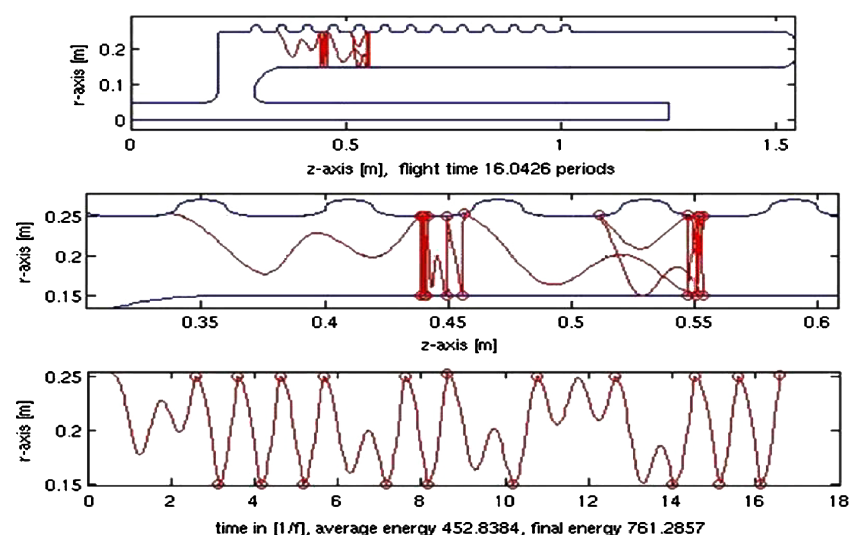
FIG. 16. (Color) Discontinuities in the resonant electron’s trajectory with a gap of 2 cm between ripples, even for only 20